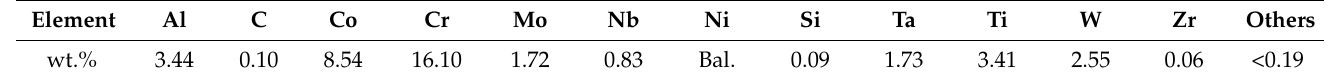
Table 1. Chemical composition of the Inconel 738LC metal powder.